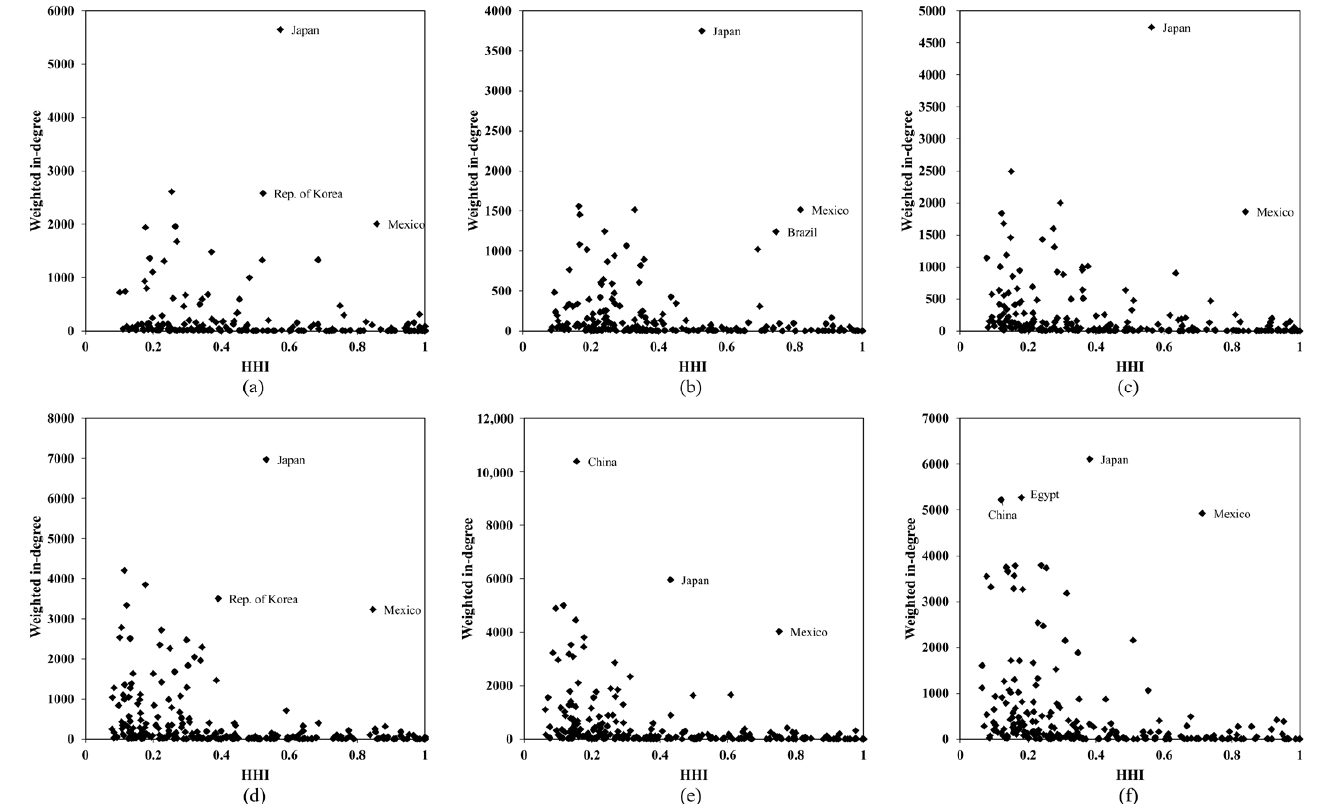
Figure 6. Scatter plots of HHI and import volume: ( a ) represents the scatter plot of 1996, ( b ) represents the scatter plot of 2000, ( c ) represents the scatter plot of 2005, ( d ) represents the scatter plot of 2010, ( e ) represents the scatter plot of 2015, and ( f ) represents the scatter plot of 2019.